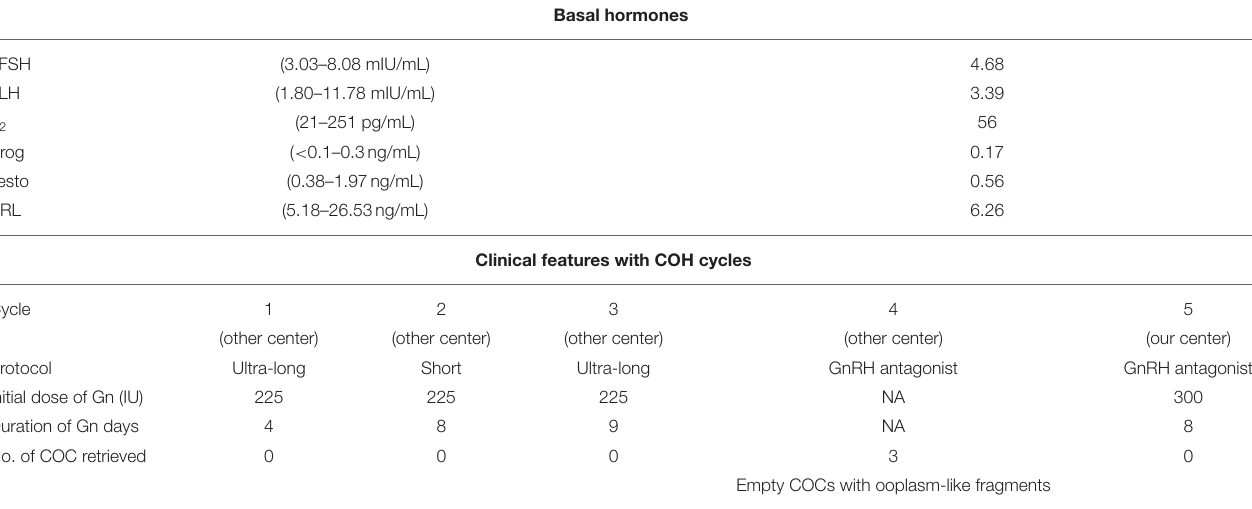
TABLE 1 | Clinical features of the EFS patient with a heterozygous ZP3 deletion.